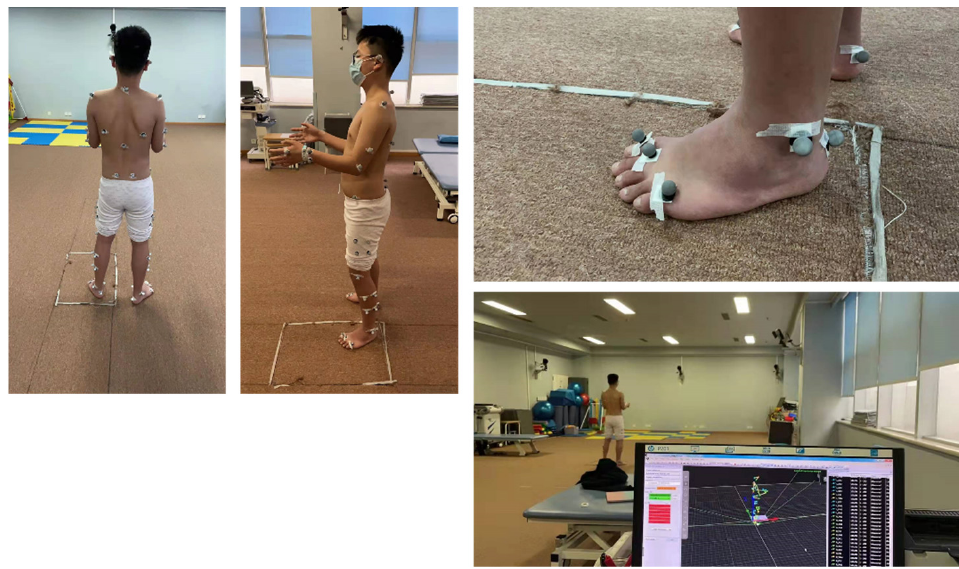
Figure 8. The 3D gait analysis of cavus foot pre-operation.